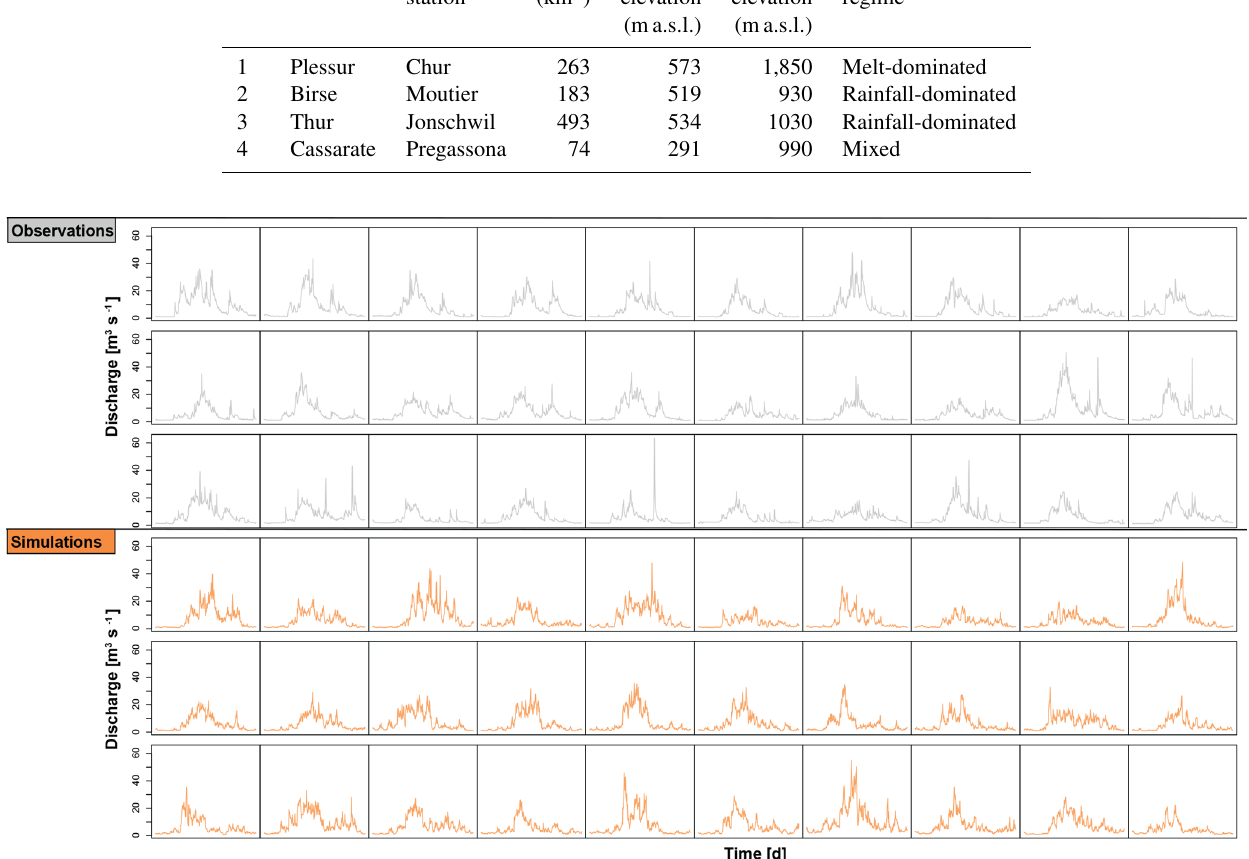
Figure 2. Observed (grey) and stochastically generated (orange) annual hydrographs at daily resolution over 30 years for the Plessur catch-